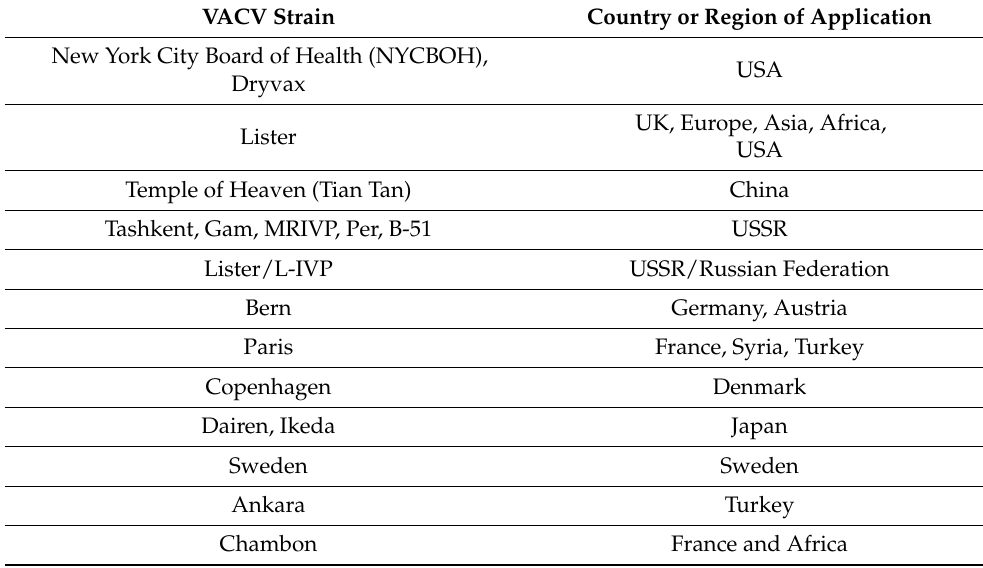
Table 1. List of the first VACV strains used for vaccination